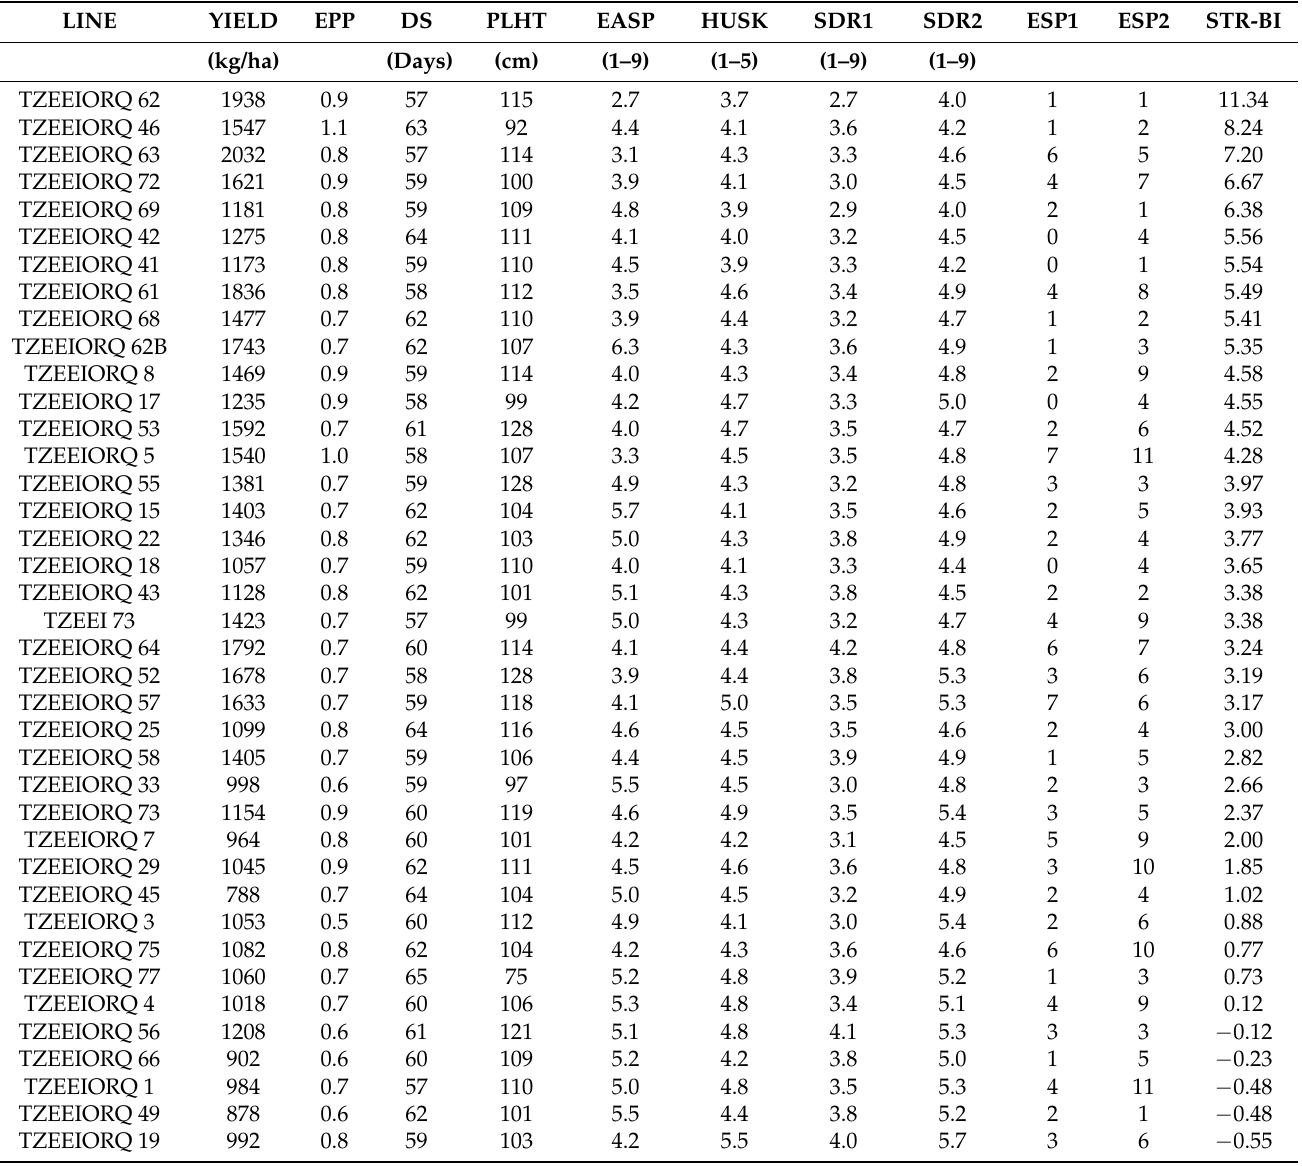
Table 4. Grain yield and other agronomic traits of 76 extra-early provitamin A quality protein maize inbreds with four checks evaluated under Striga -infested environments at Abuja and Mokwa in Nigeria in 2016 and